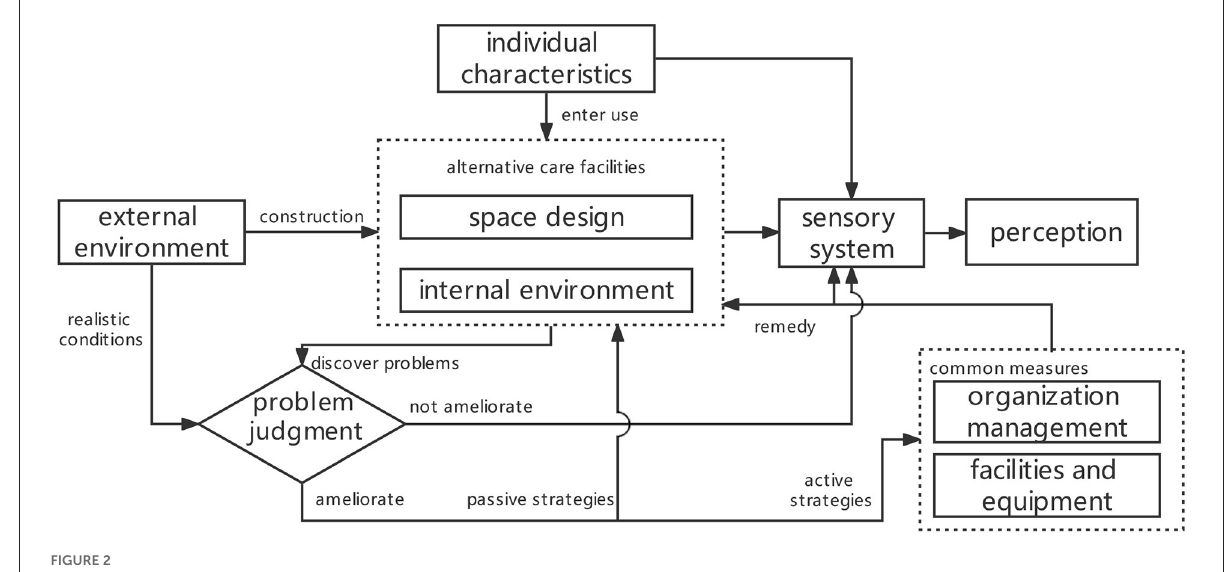
FIGURE2 Interaction mechanism between main categories.